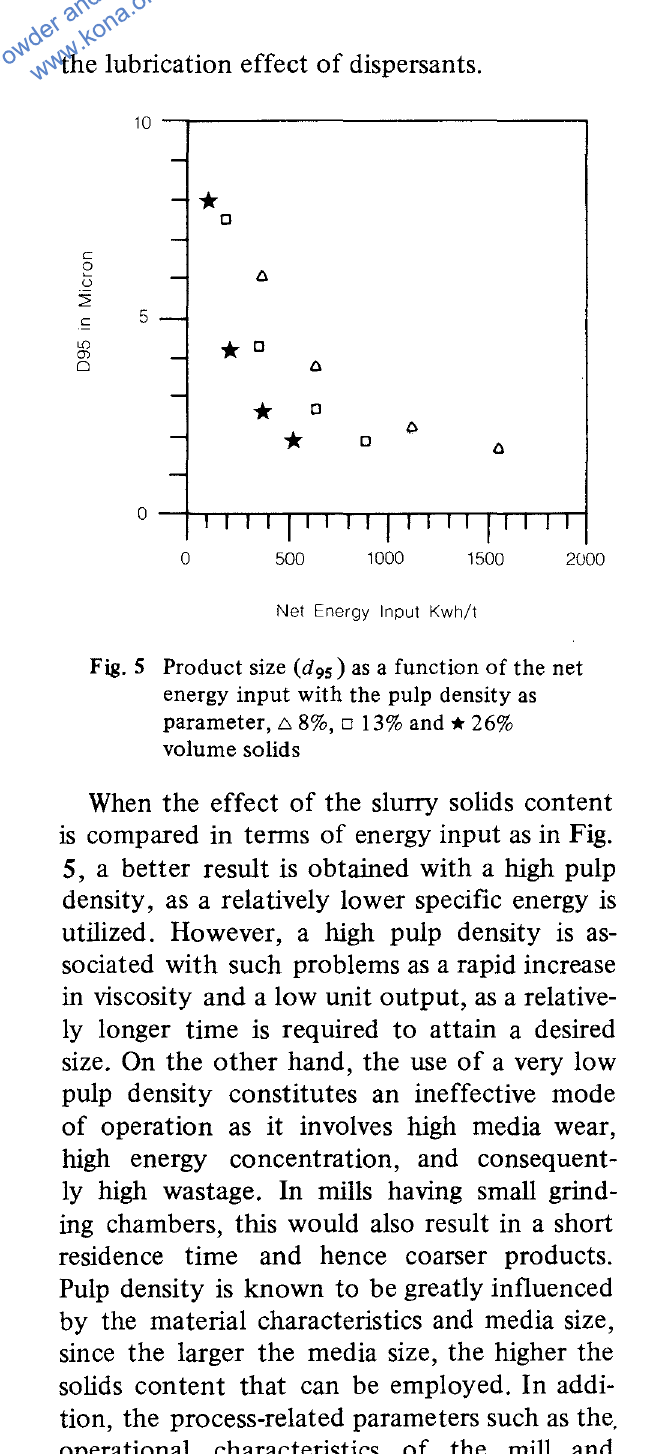
Fig. 5 Product size (d 95 ) as a function of the net energy input with the pulp density as parameter, 6 8%, o 13% and* 26% volume solids